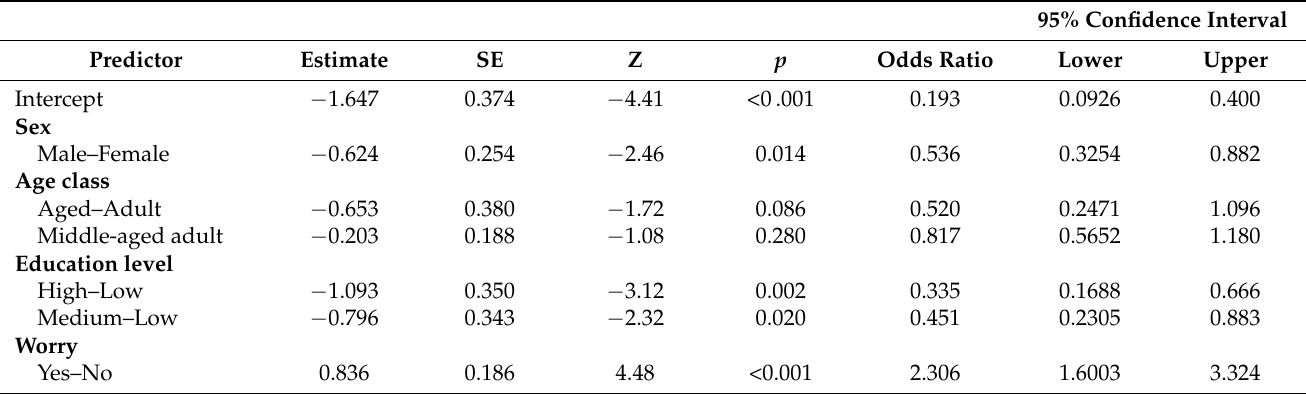
Table A6. Results of Multivariate Regression Analysis Models, with Quality of Sleep as Dependent Variable and Feeling of Worry and Sociodemographic Characteristics as Independent Variables.